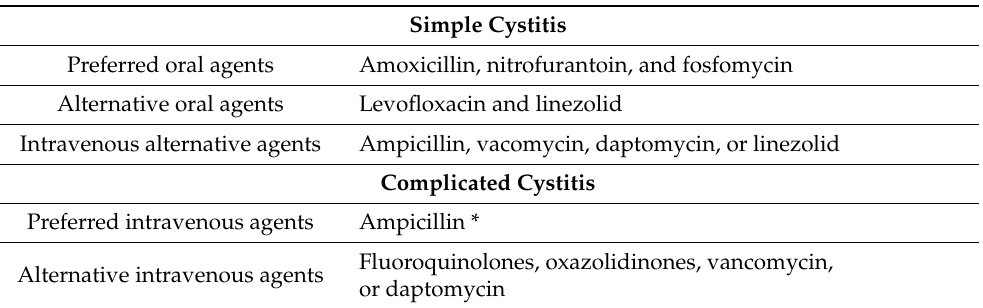
Table 3. Therapeutic agents for the treatment of simple and complicated